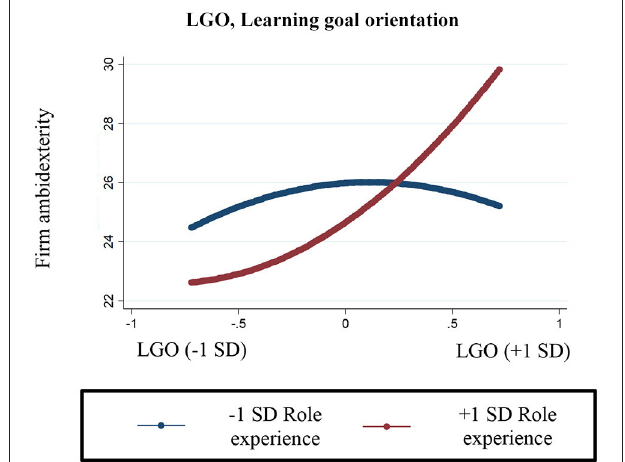
FIGURE 2 | Interaction of top decision makers’ learning goal orientation role experience on firm ambidexterity. teams and leaders” (O’Reilly and Tushman, 2004: p.